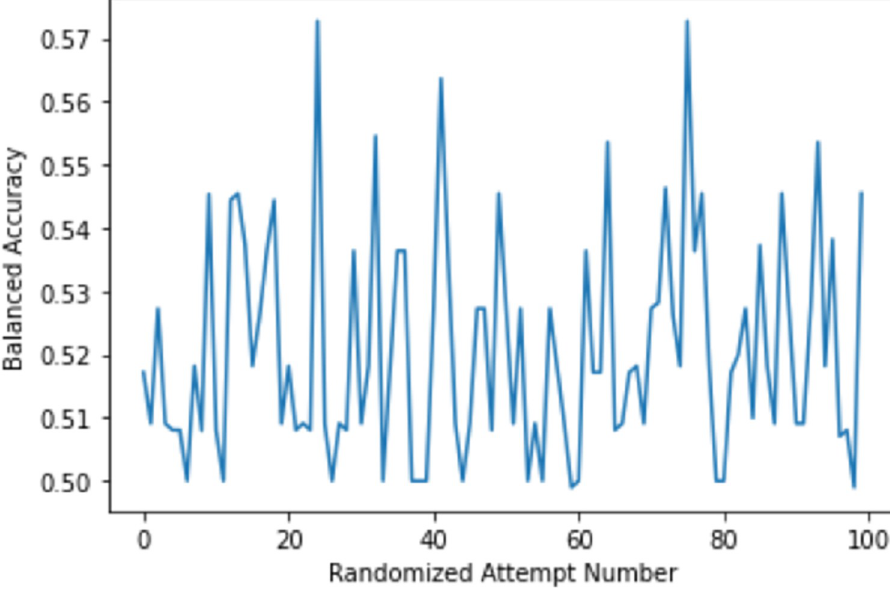
Fig 8. The balanced accuracy scores that were achieved by running 100 random labeled models. The X-axis is the attempt number. Y-axis indicates the balanced accuracy score.